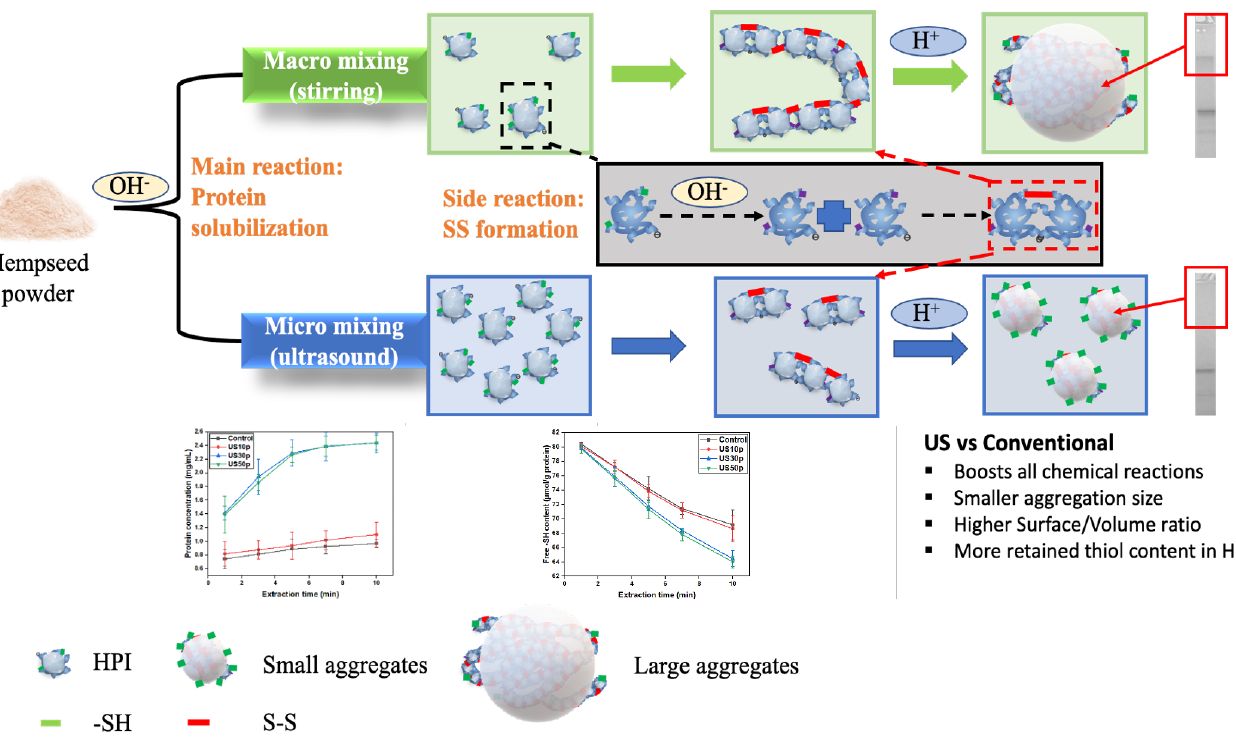
Figure 4. The schematic mechanism of the conventionally extracted and US-assisted extracted hempseed protein system.